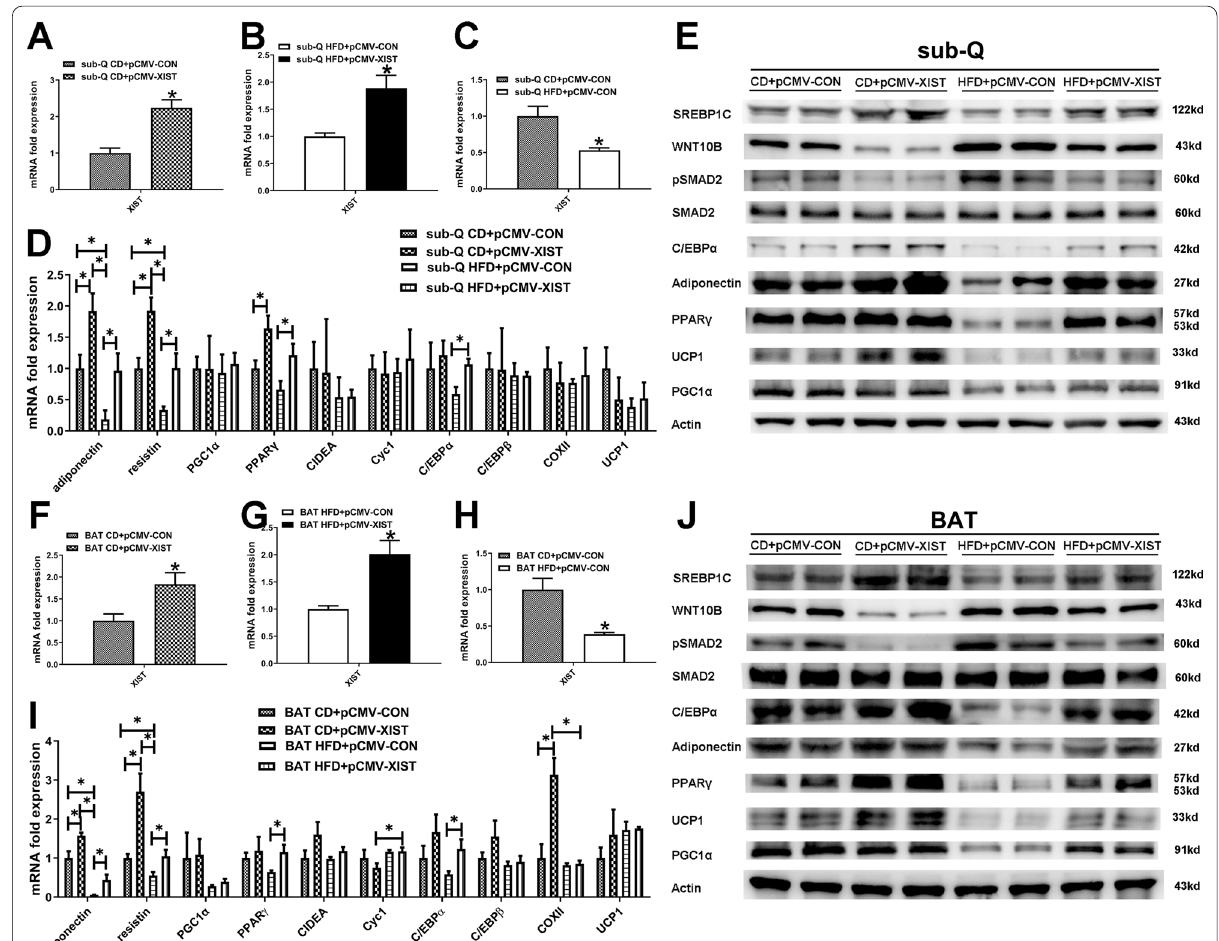
Fig. 6 XIST overexpression effect on metabolism-related gene expression of adipose tissues in HFD-induced mice. A – D , F – I qRT-PCR analysis of XIST and indicated gene expression in sub-Q and BAT from male mice after intervention. *, p < 0.05. E , J Western blot analysis of indicated protein expression in sub-Q and BAT from male mice after intervention. CD, chow diet; HFD, high-fat diet; pCMV-CON, tail vein injection of control plasmid; pCMV-XIST, tail vein injection of XIST overexpression plasmid; BAT, brown adipose tissue; sub-Q, subcutaneous adipose tissue; LDL-C, low-density lipoprotein cholesterol; HDL-C, high-density lipoprotein cholesterol. Data are represented as mean ±